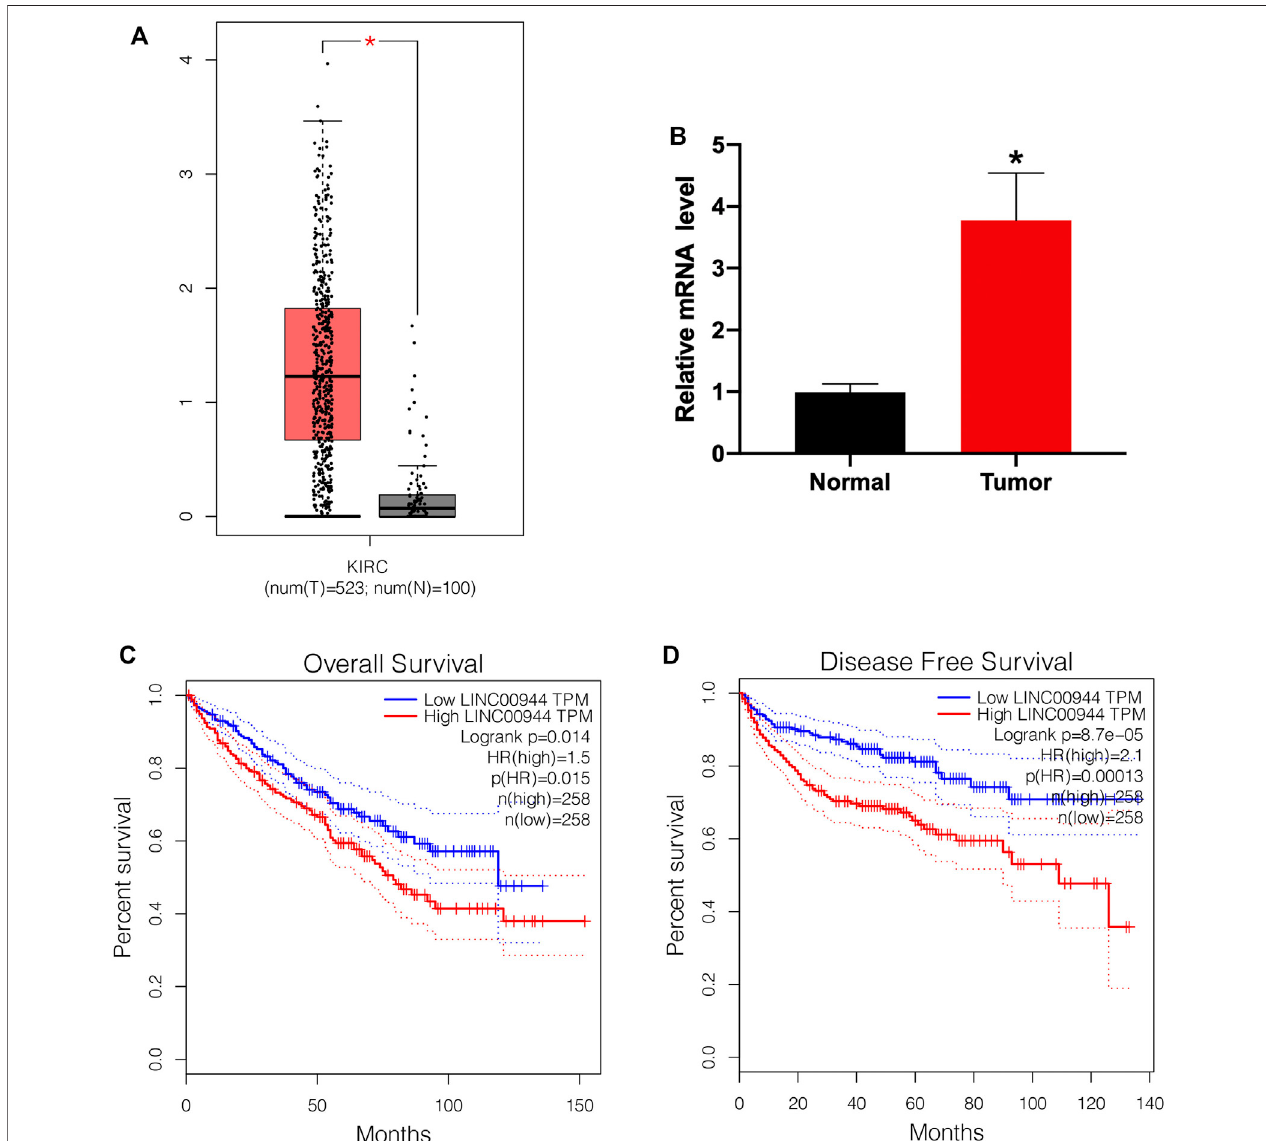
FIGURE1| TheexpressionleveloflncRNALINC00944wassigni fi cantlyincreasedinRCCpatients. (A) LINC00944expressionlevelsintumorandadjacenttissues fromtheTCGAdatabase. (B) ExpressionlevelsofLINC00944intenRCCpatientsdetectedbyqRT-PCR. (C) Kaplan – MeiersurvivalcurvesofLINC00944inRCCtissues from the TCGA database. (D) Disease-free survival curves of LINC00944 in RCC tissues from the TCGA database. * p < 0.05.